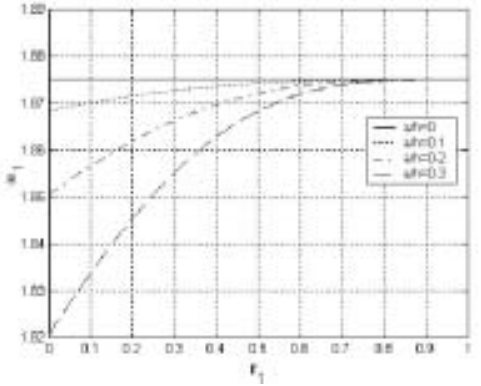
Fig. 8. The first natural frequency parameter of the beam in vacuum as a function of the position of the crack.